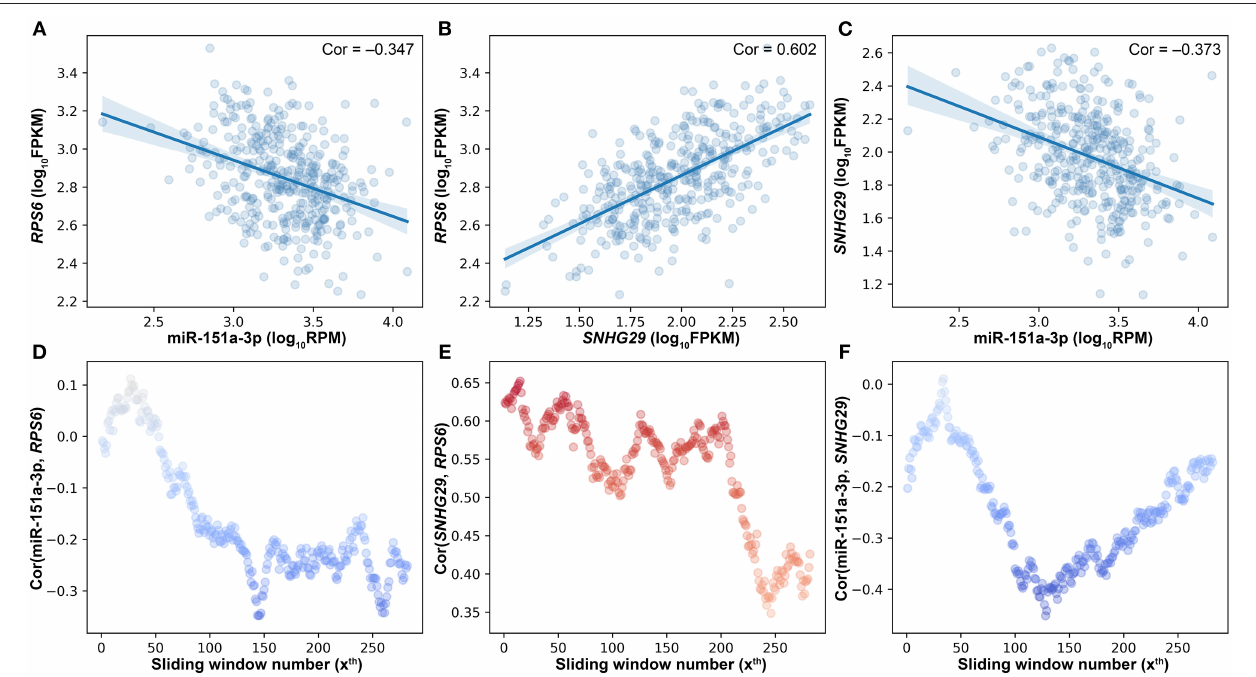
FIGURE 4 | The pairwise interaction impacted by the other one in triplets. (A) The scatter plot of miR-151a-3p and RPS6 . (B) The scatter plot of SNHG29 and RPS6 . (C) The scatter plot of miR-151a-3p and SNHG29 . (D) The impact of SNHG29 on the miR-151a-3p –RPS6 interaction. (E) The impact of miR-151a-3p on the SNHG29–RPS6 interaction. (F) The impact of RPS6 on the miR-151a-3p –SNHG29